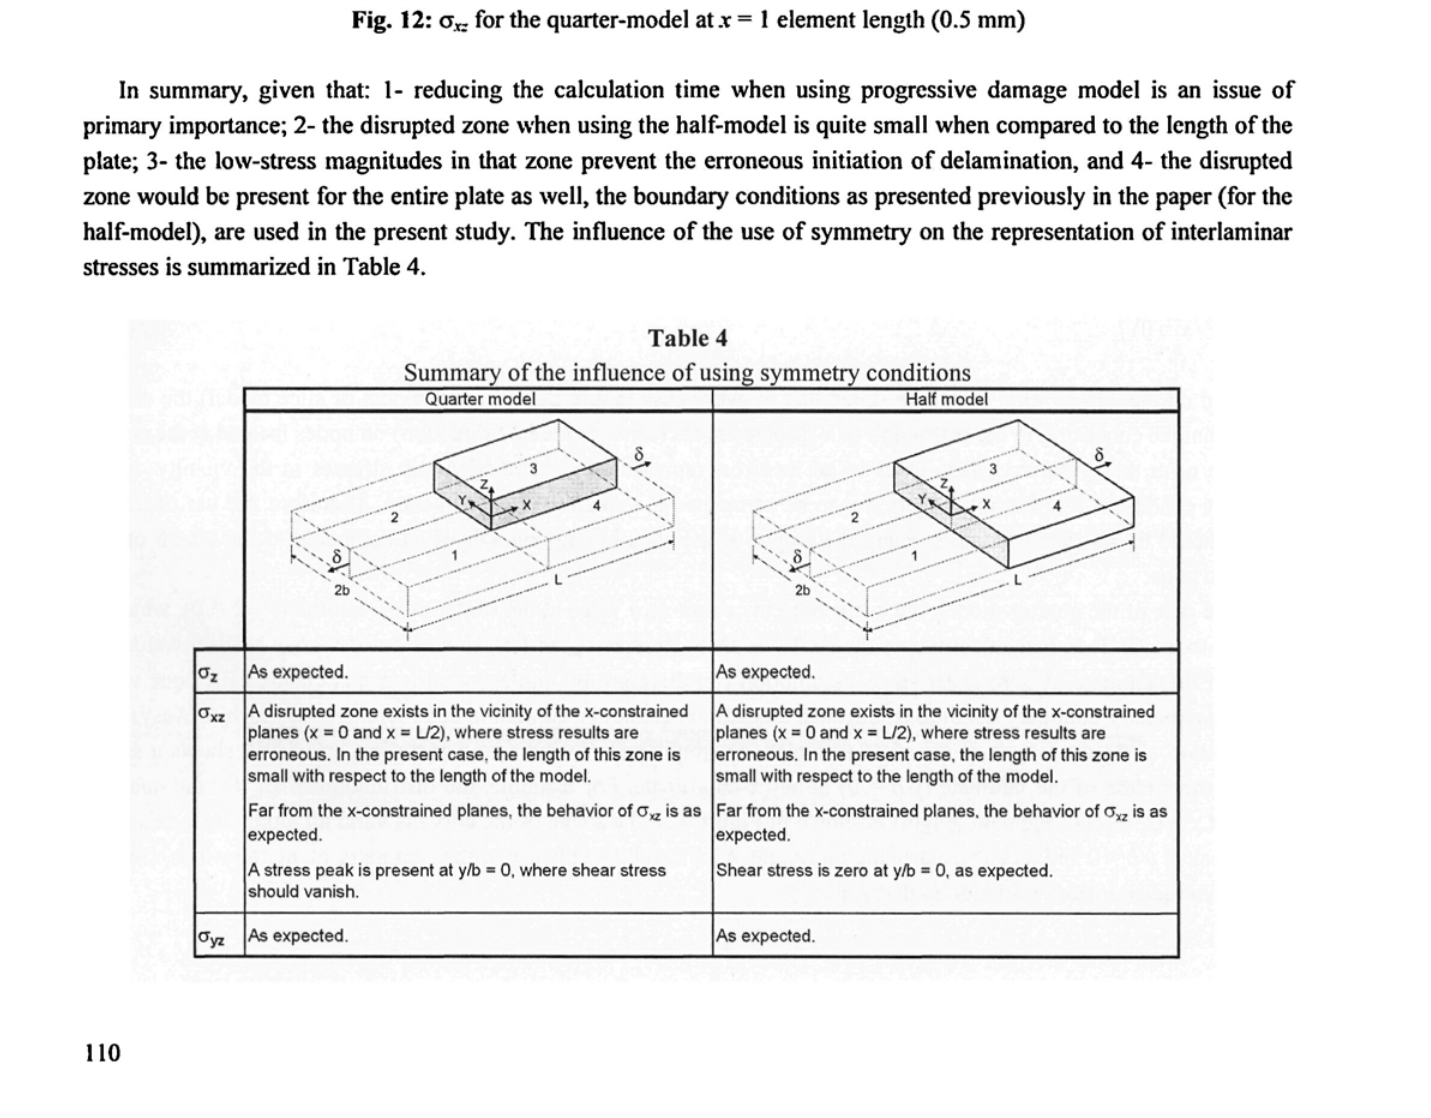
Fig. 12: a for the quarter-model at.χ = 1 element length (0.5 mm) rr